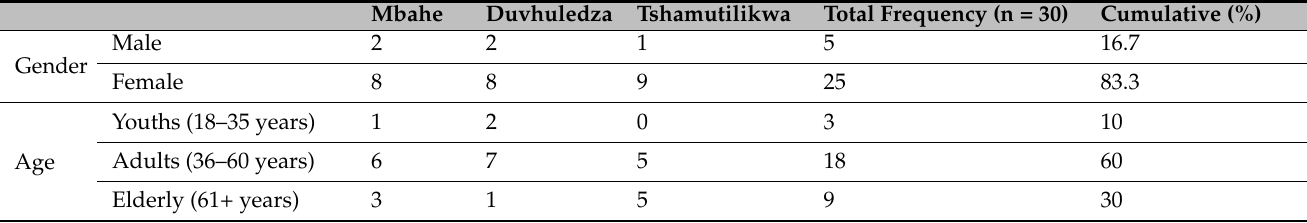
Table 1. Demographic characteristics of the respondents in the study on the perception of solar PV adoption.